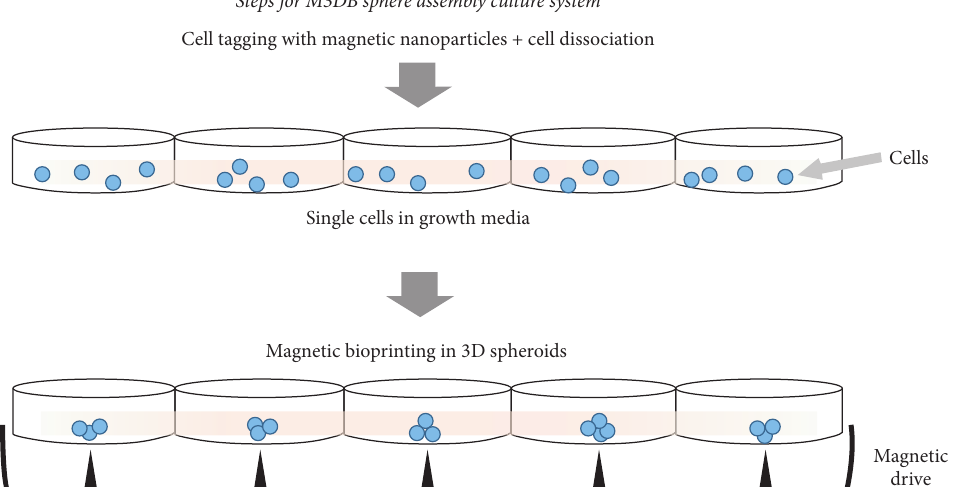
Figure 1: Diagram showing magnetic 3D bioprinting (M3DB) sphere assembly culture system by magnetic force driven patterning of tagged cells